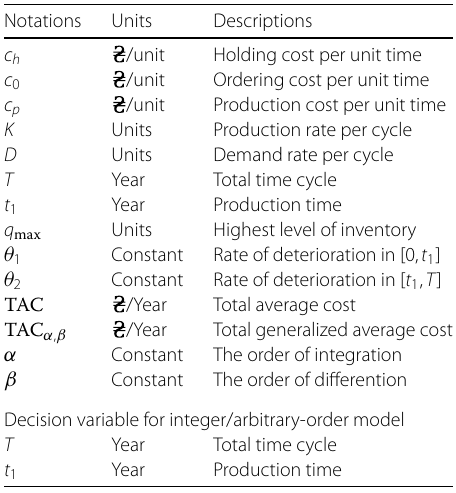
Table 2 EPQ model with deterioration